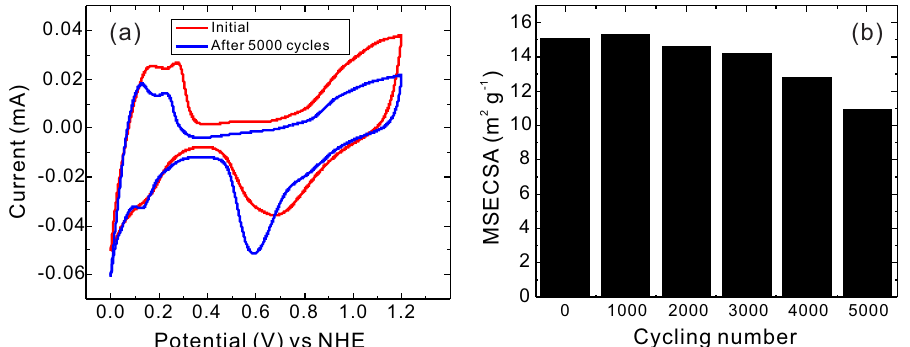
Figure 9. ( a ) cyclic voltammograms of PLD sample with 100 µ g · cm − 2 Pt loading before and after 5000 potential cycles; ( b ) MSECSA as a function of cycling